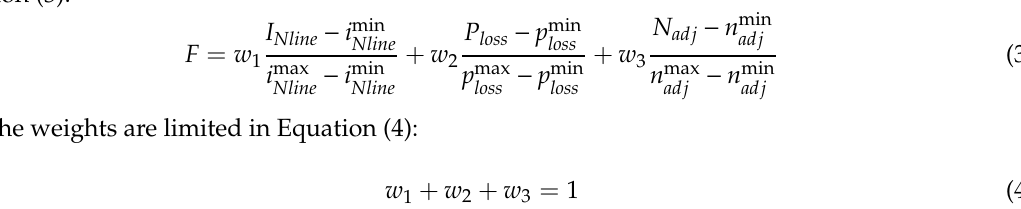
Figure 8. Illustration of the phase arrangement scheme of three-phase transformer.